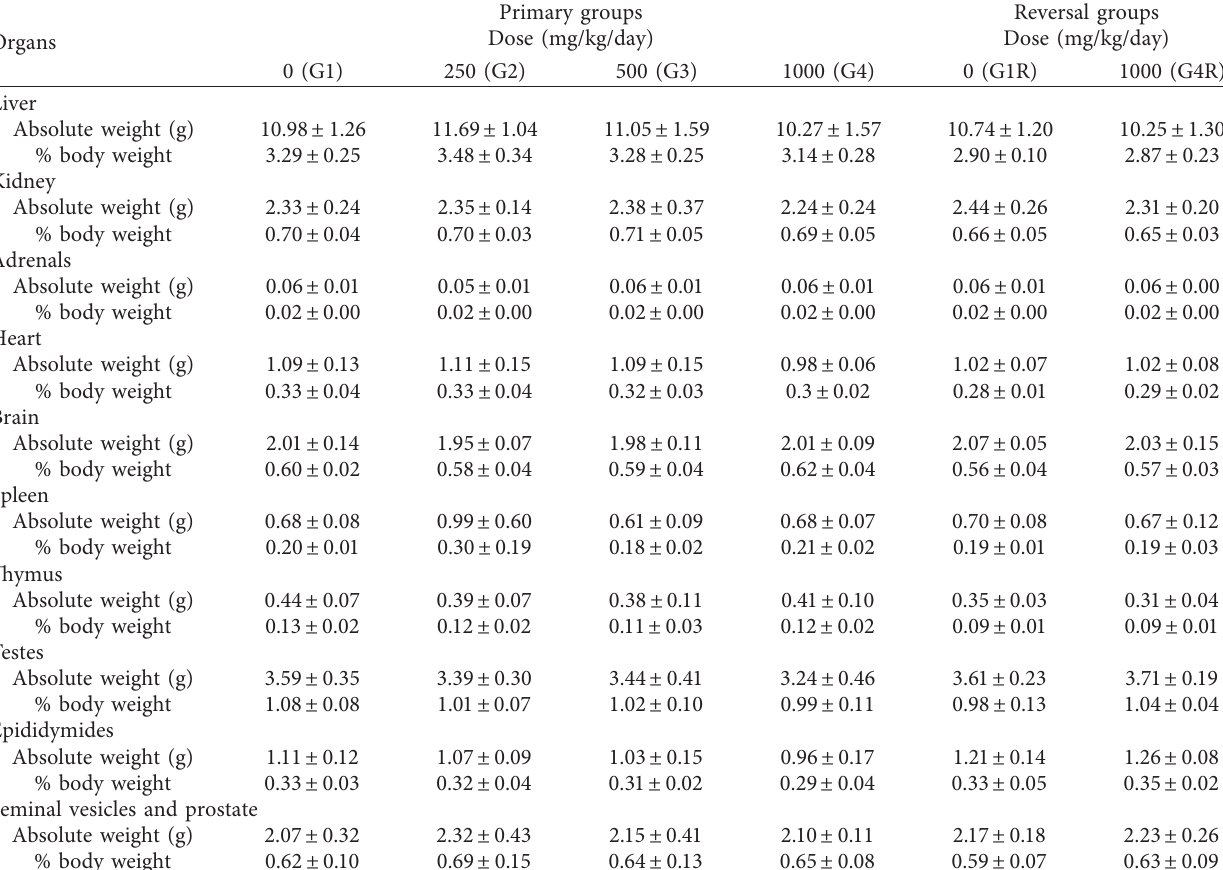
Table 5: Effect of oral administration of GMCT on absolute and relative organ weights of male Wistar